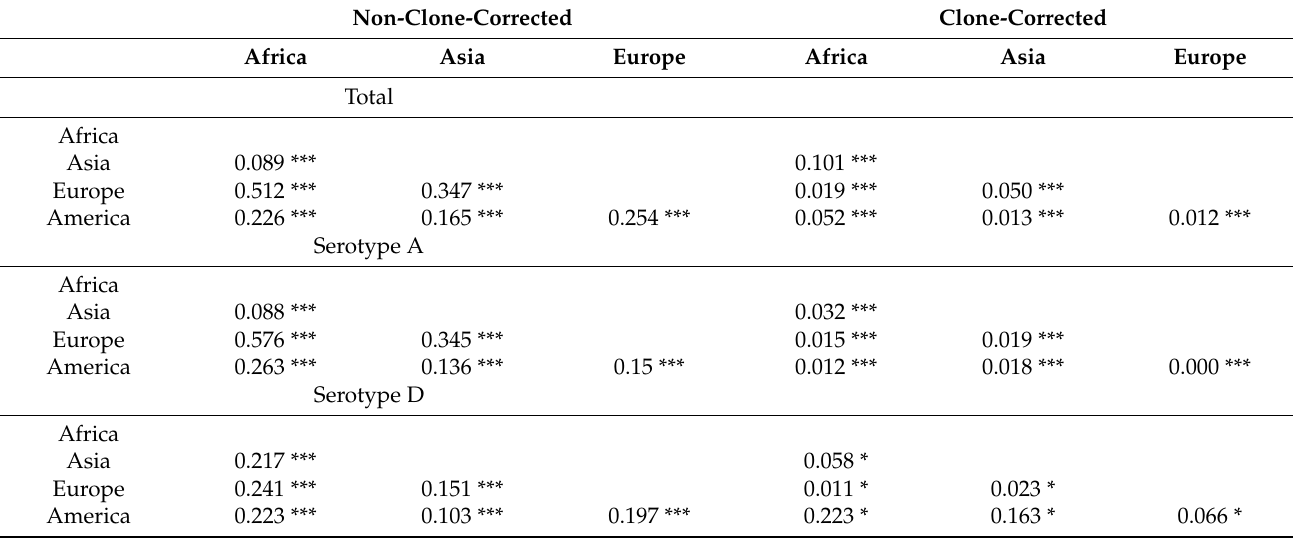
Table 6. Pairwise population comparison at the continental level.